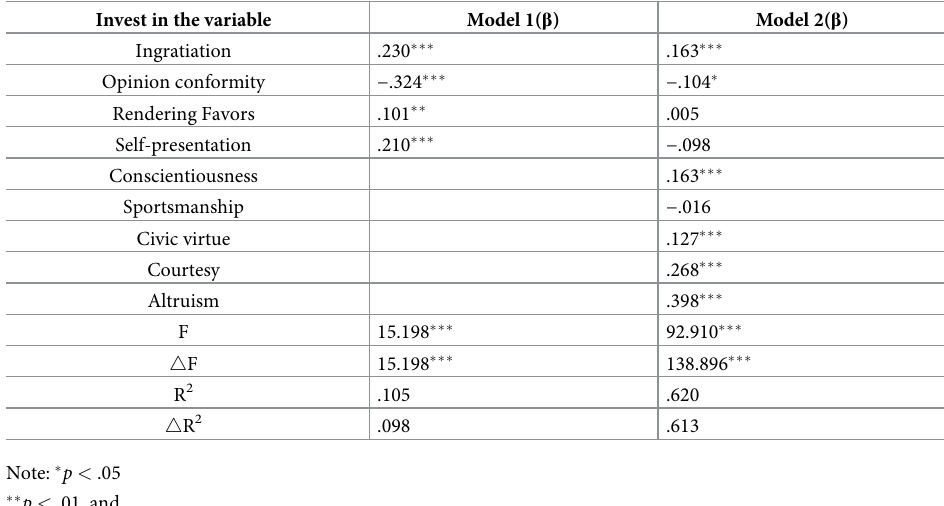
Table 5. Regression analysis of impression management and organizational citizenship behaviors on job